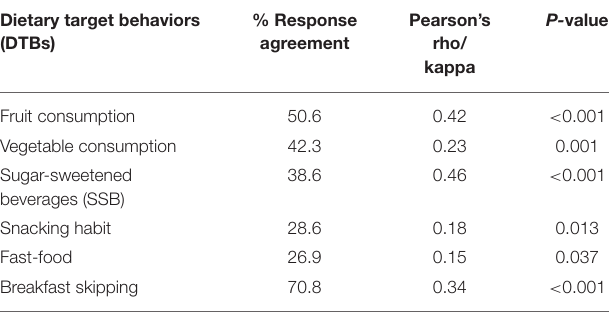
TABLE 6 | Correlation analysis between the use of the e-Diary and the change in target behaviors. Dietary target behaviors